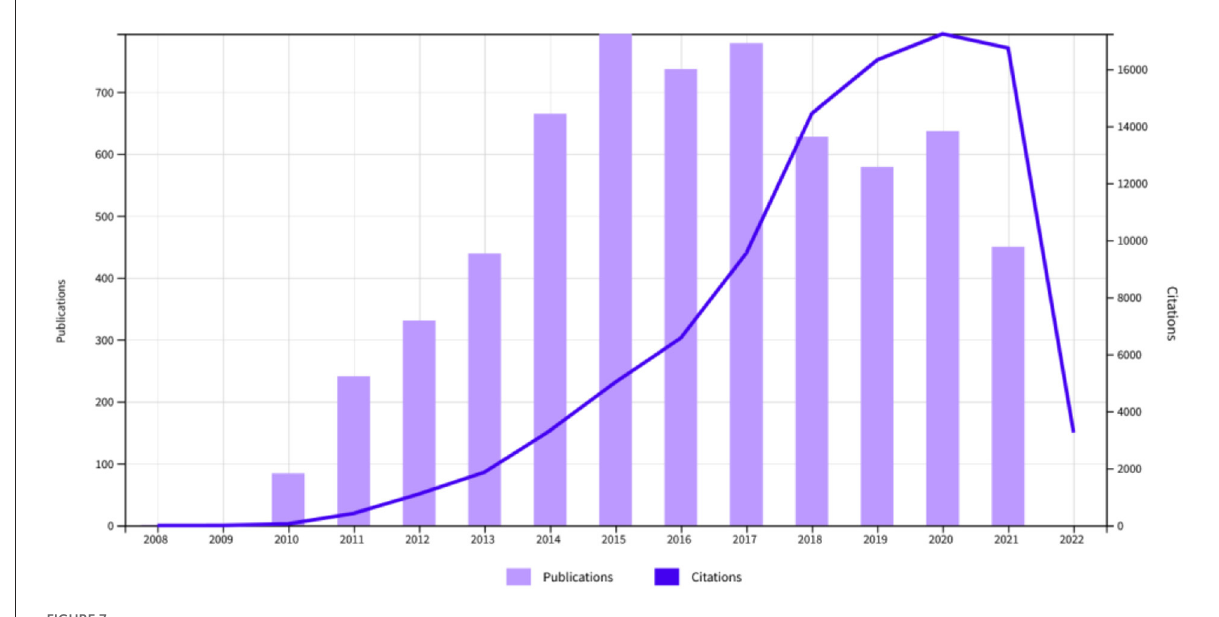
FIGURE7 Changes in the number of publications and citations on the